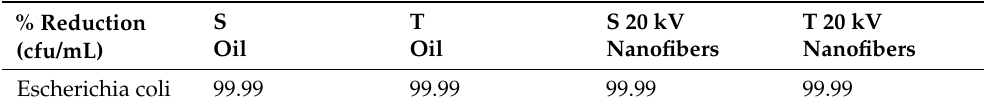
Table 9. Intensity of other characteristic bands of the FTIR spectrum of the less-relevant thyme- essential-oil nanofiber